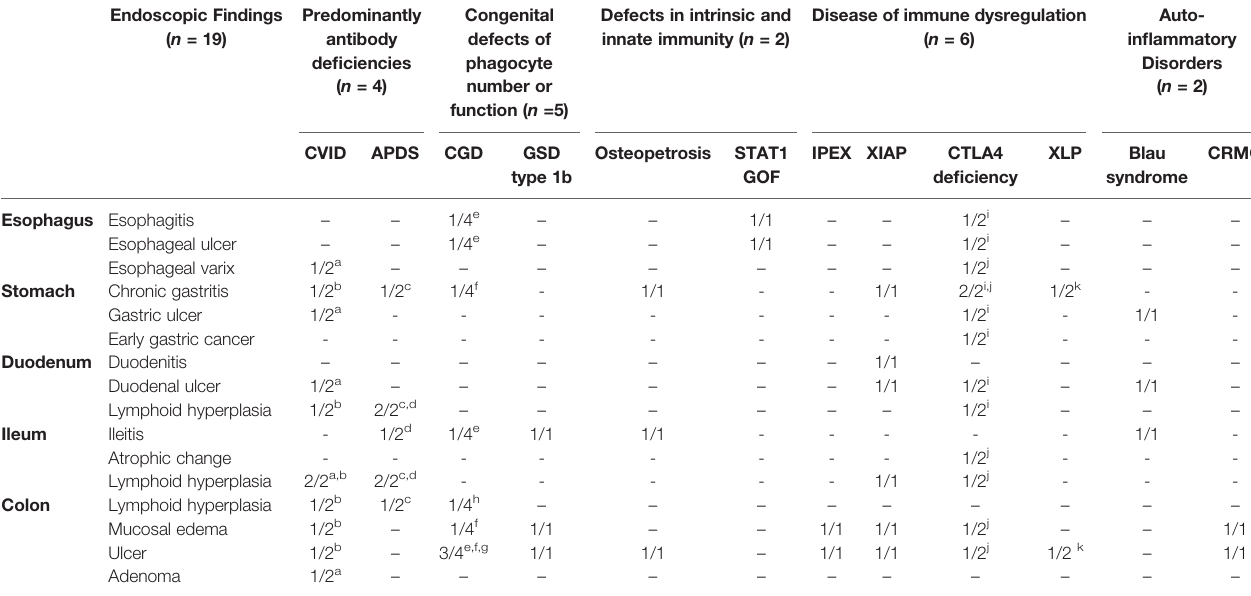
TABLE 4 | Endoscopic fi ndings in patients with inborn errors of immunity. Endoscopic Findings ( n =